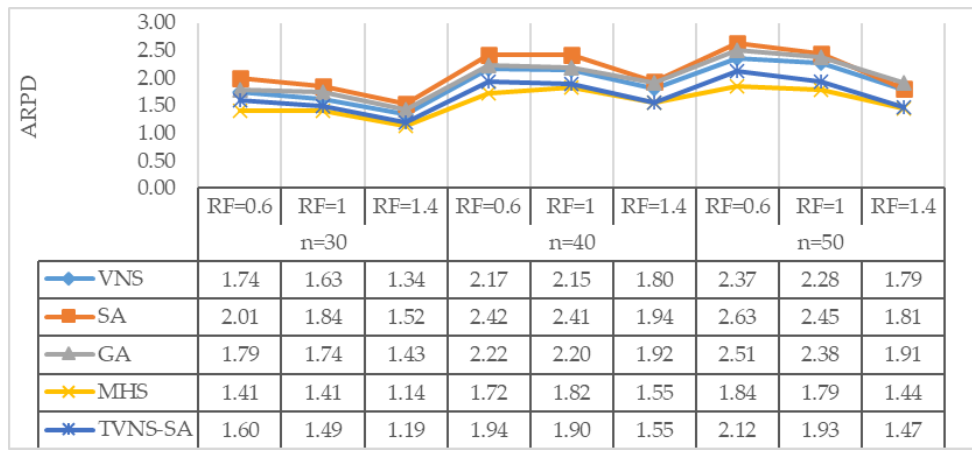
Figure 10. Computational results with a different range of release dates.